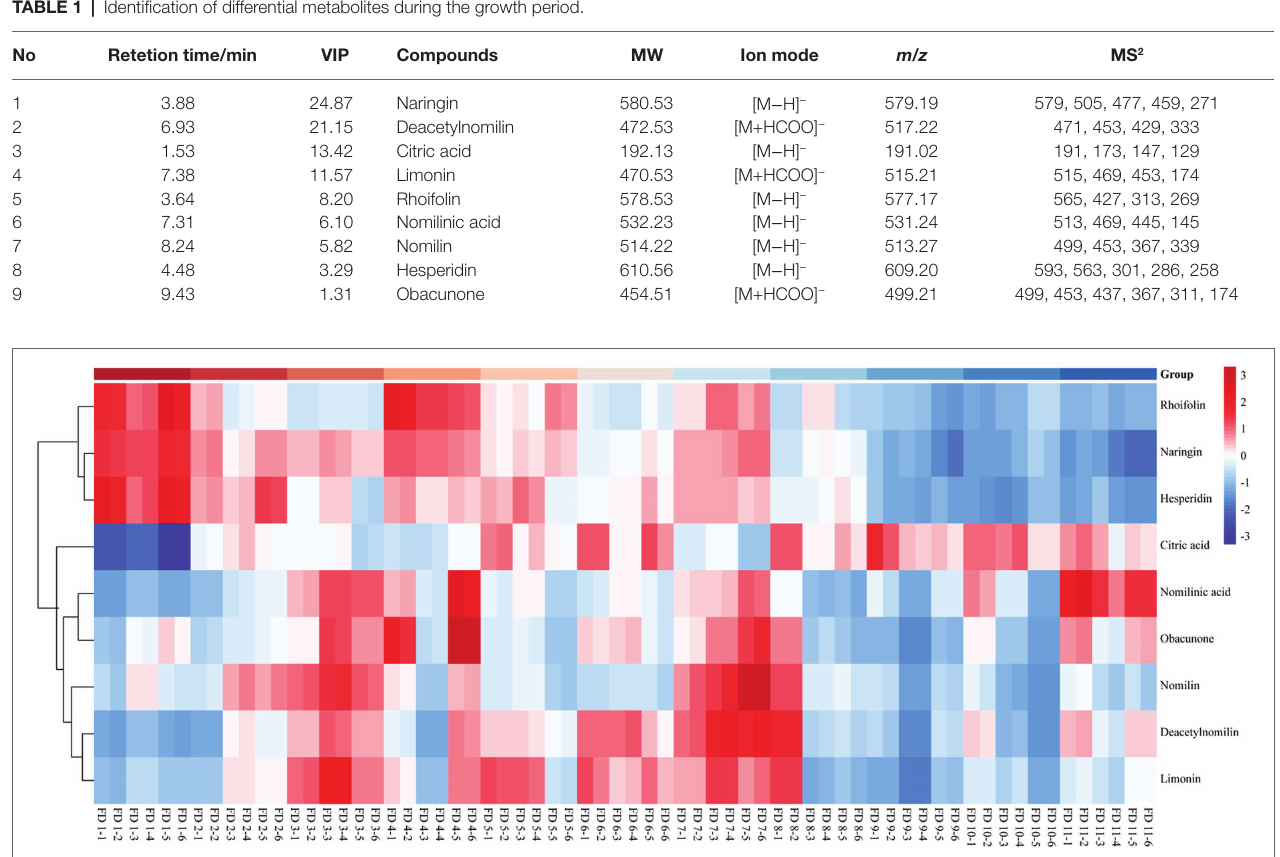
FIGURE 8 | Heatmap of relative content of differential metabolites in different color